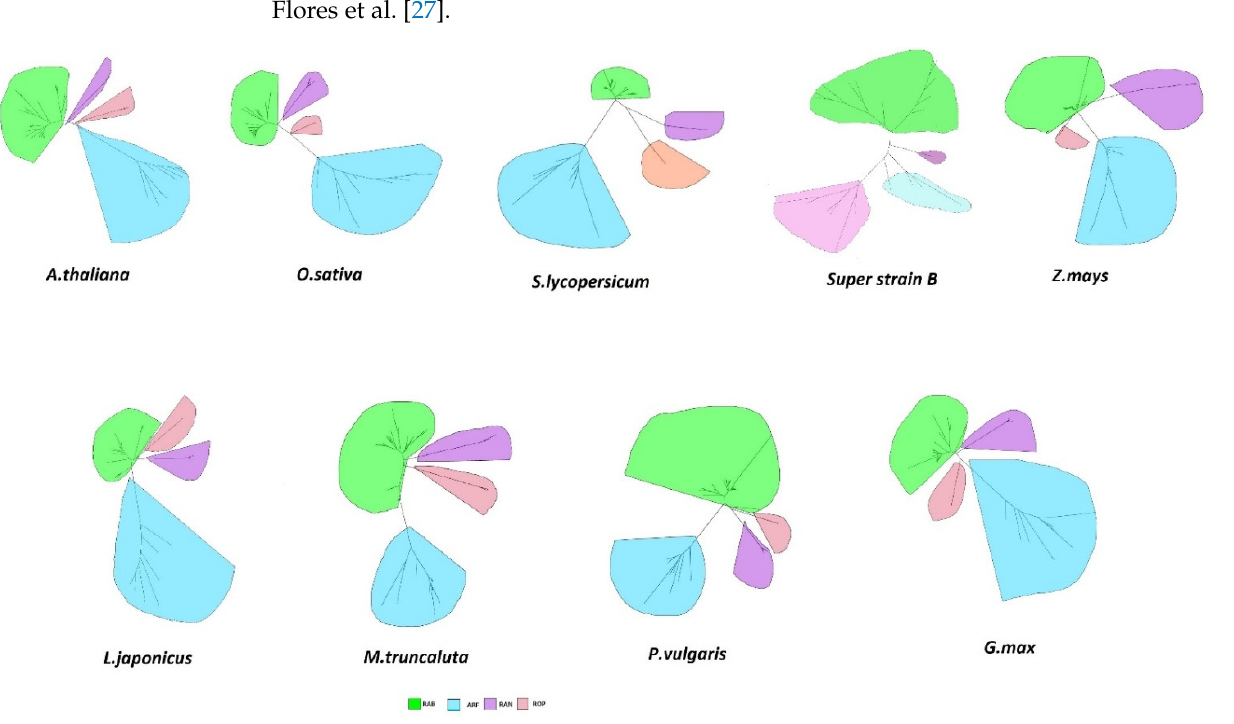
Figure 1. Phylogenetic analysis of the small GTPase superfamily in S. lycopersicum super strain B and other legume and non-legume plants. Amino acid sequences corresponding to small GTPases from O. sativa , A. thaliana , S. lycopersicum , L. japonicus , Z. mays , M. truncatula , G. max , and P. vulgaris were restored from genomic databases. Unrooted neighbor-joining trees were obtained using the Mega 7 software. Subfamilies were recognized for each species: Rab (green), Arf (blue), Rop (Pink), and Ran